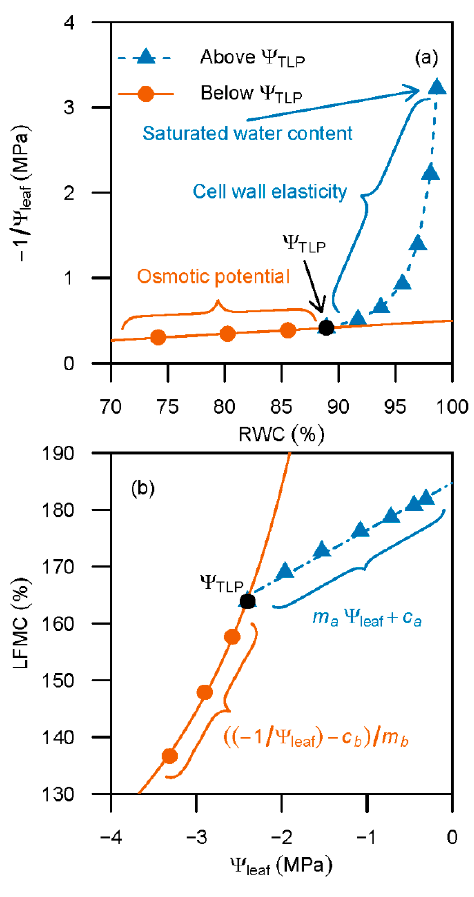
Figure 2. ( a ) Pressure–volume curve illustrating the non-linear relationship between − 1 / Ψ leaf and declining water status (RWC) (when Ψ leaf > Ψ TLP ), and the linear relationship (when Ψ leaf < Ψ TLP ). Additionally shown is the turgor loss point ( Ψ TLP ), saturated water content, and region of the graph affected by cell wall elasticity and osmotic potential at full hydration. ( b ) Relationship between live fuel moisture content (LFMC) and Ψ leaf above and below the Ψ TLP , derived from pressure-volume curve relationships. Note, this is a theoretical relationship and not based on observations.